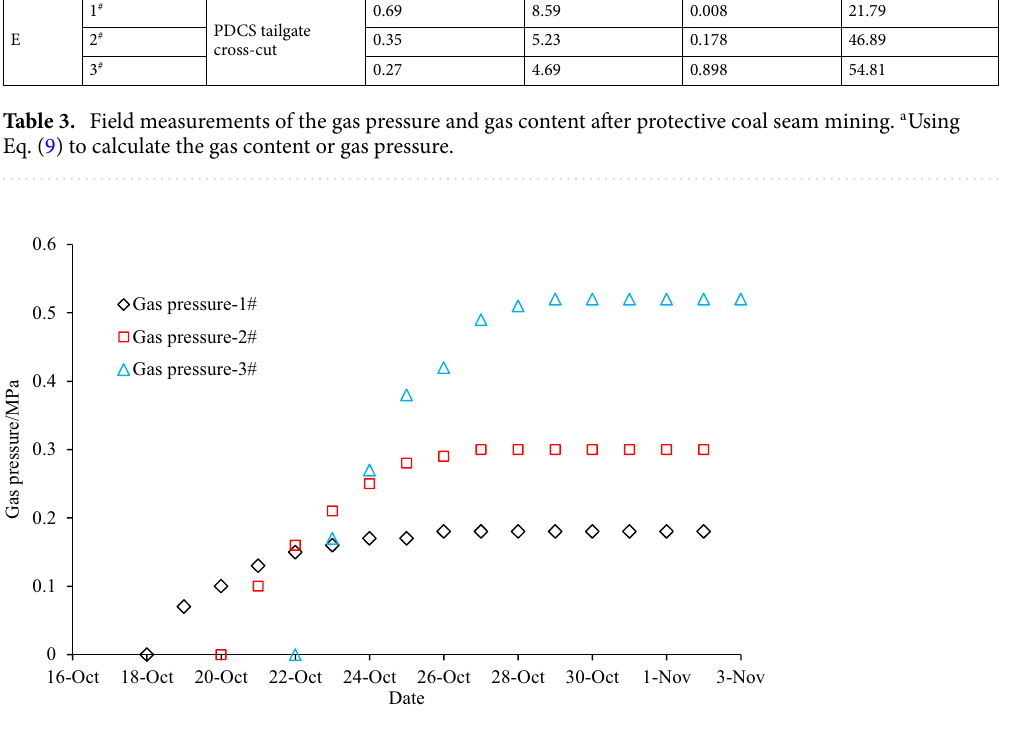
Figure 7. Gas pressure after protective coal seam